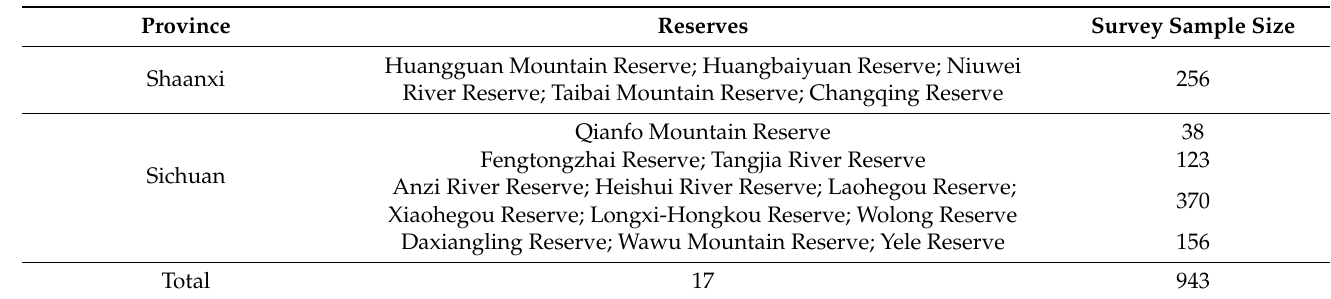
Table 2. Study area and sample